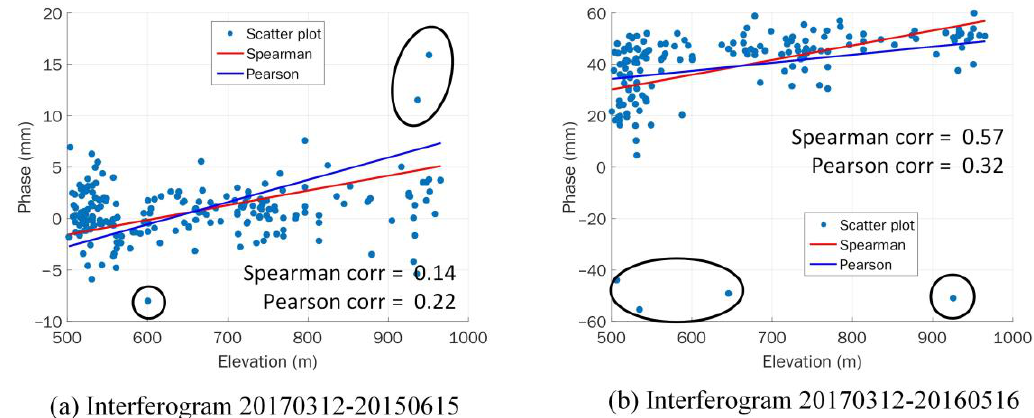
Figure 10. Example scatter plots of phase vs. elevation with least-squares reference lines. Outliers have been marked with black circles or ellipses. The phase values have been converted to millimeters. ( a ) Interferogram 20170312-20150615 with a 30 km window size, after tropospheric correction using ERA5 and spatiotemporal filtering; ( b ) interferogram 20170312-20160516 with a 30 km window size, after tropospheric correction using the GACOS product.